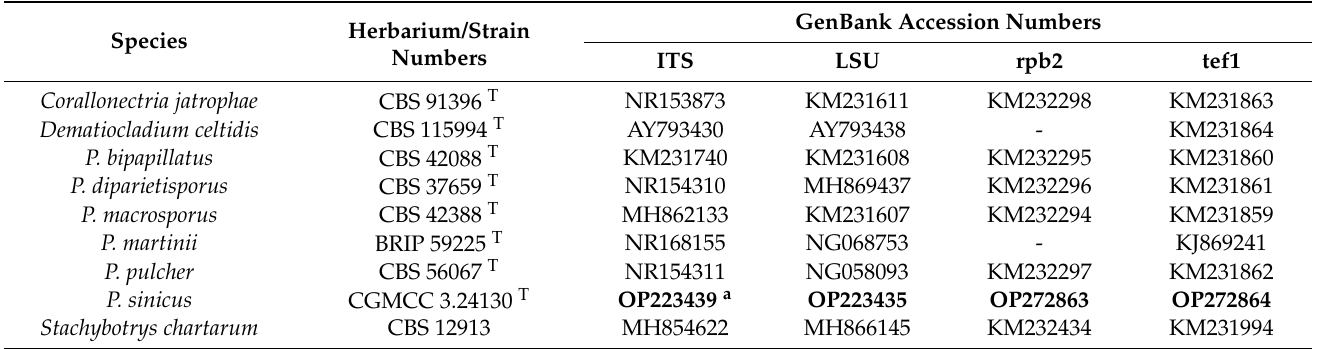
Table 1. List of Penicillifer species, herbarium/strain numbers, and GenBank accession numbers of materials used in this study.